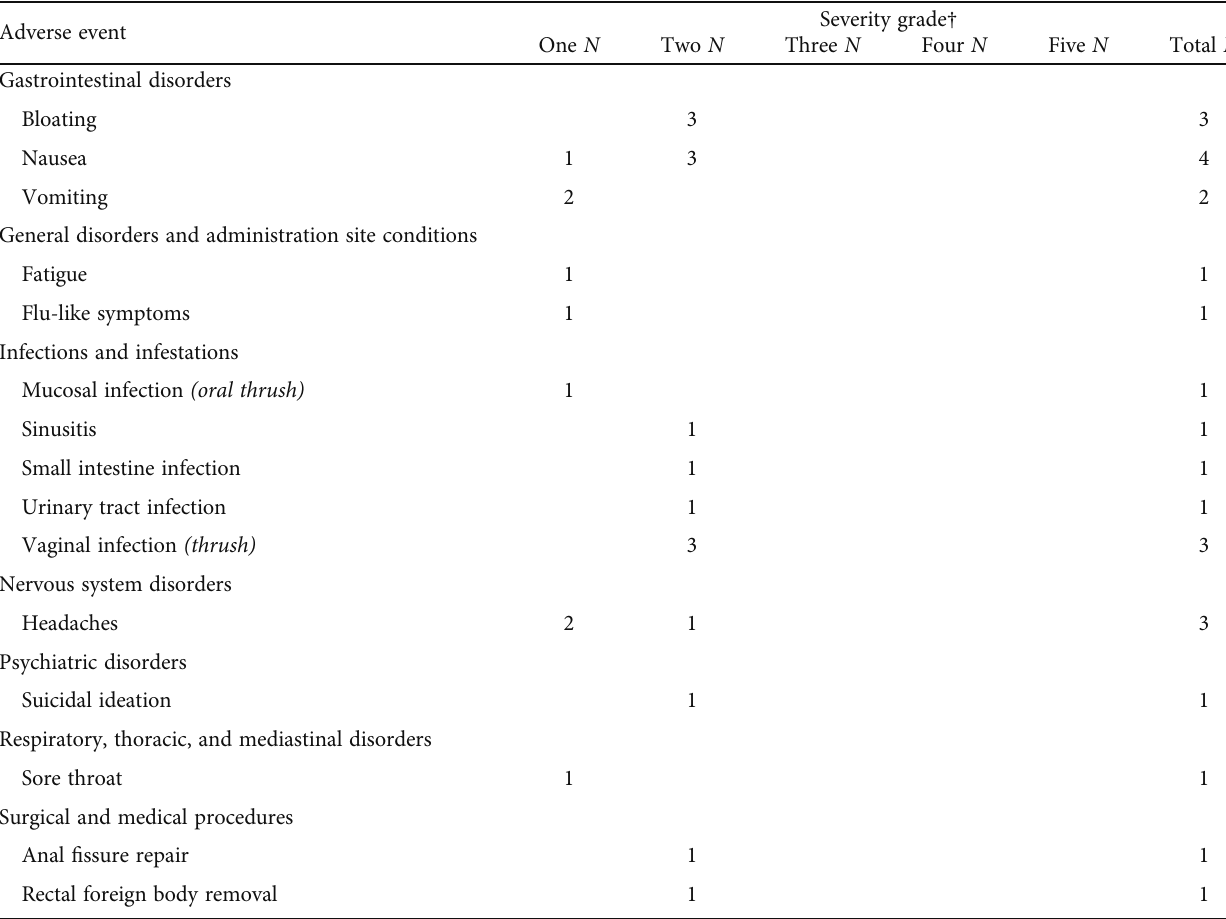
Table 5: Common terminology criteria for adverse events (CTCAE) grading of participant reported adverse events during FMT ( N = 60 ). Adverse